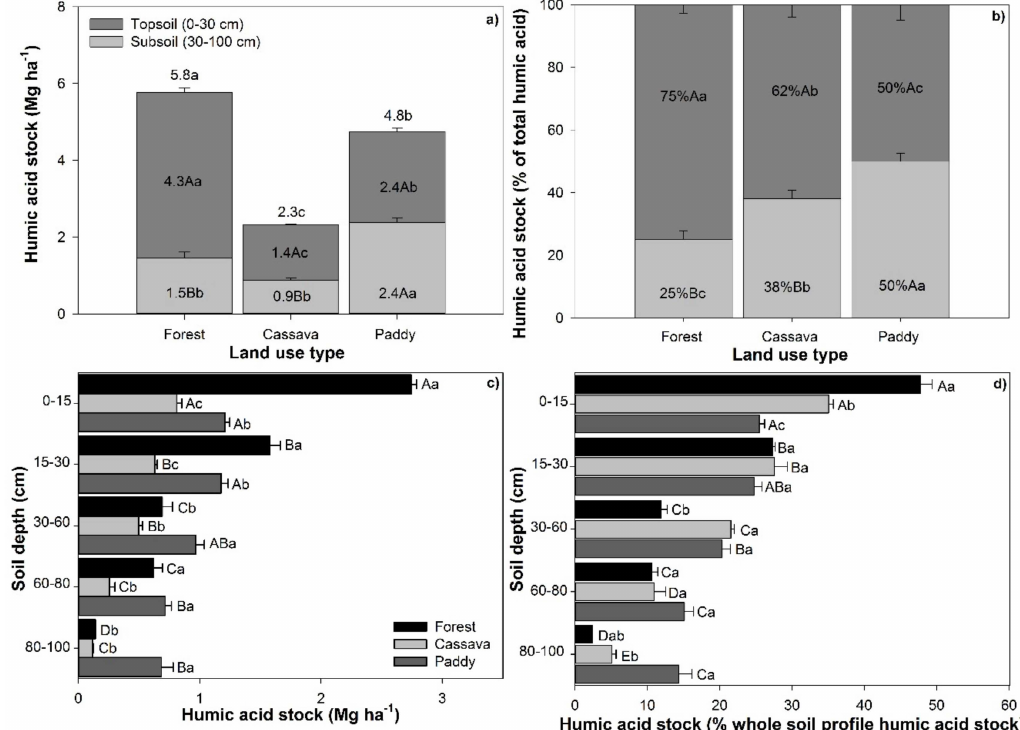
Figure 4. Land use changes a ff ecting humic acid stocks in the whole soil profile, topsoils, and subsoils: ( a ) humic acid stocks (Mg ha − 1 ), ( b ) whole humic acid stocks (percentage of whole soil profile humic acids stock), ( c ) distribution of humic acid stocks (Mg ha − 1 ), and ( d ) distribution of humic acid stocks (percentage of whole soil profile humic acids). Uppercase letters accompanying bar graphs denote comparisons of humic acid stocks among di ff erent soil depths within a land use type. Lowercase